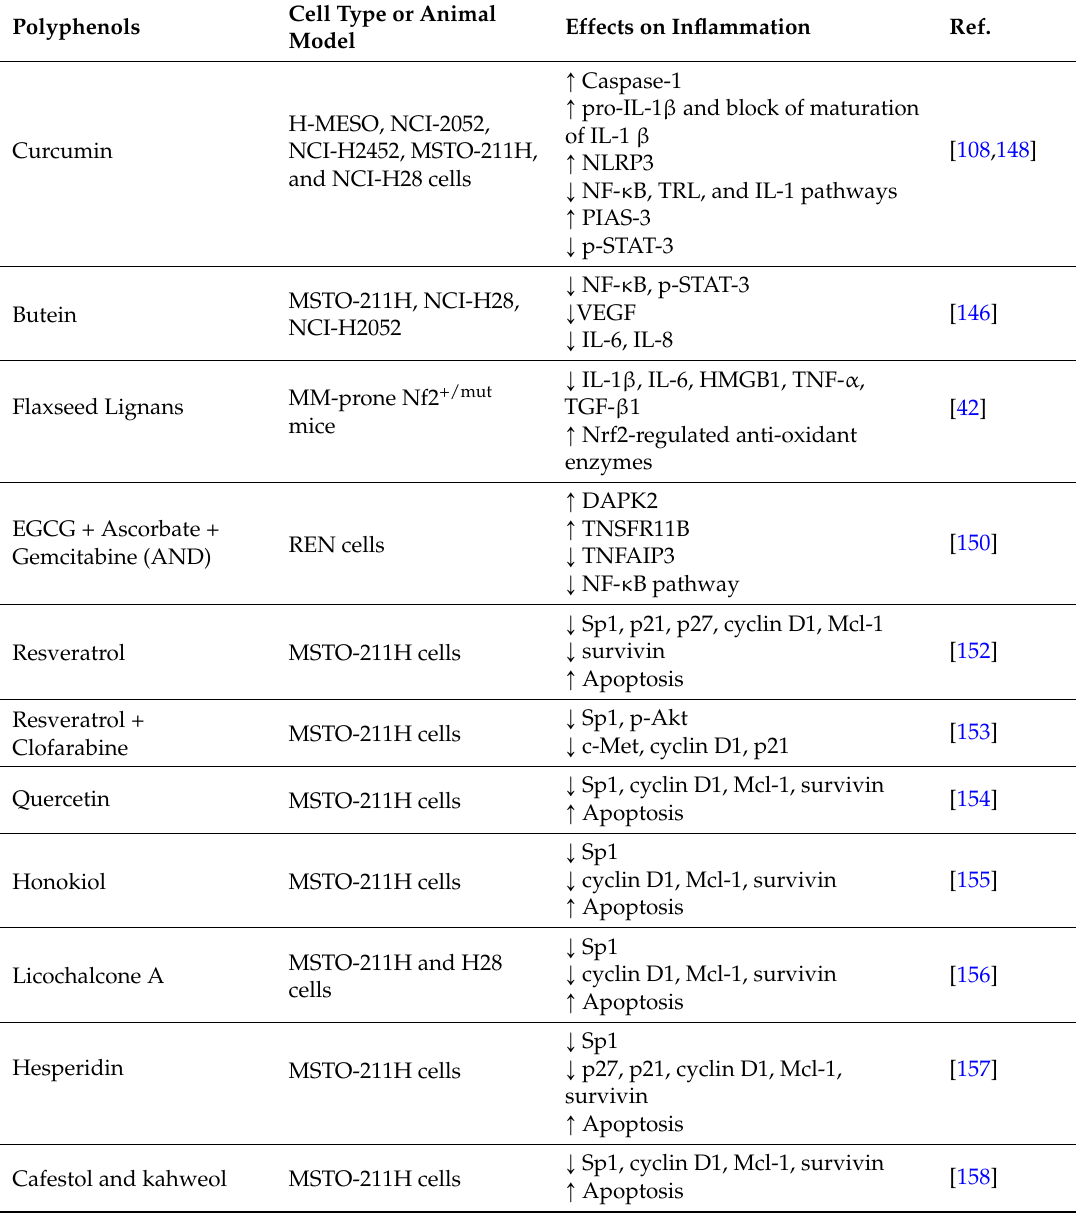
Table 2. Effects of polyphenols on production of mediators of inflammation in